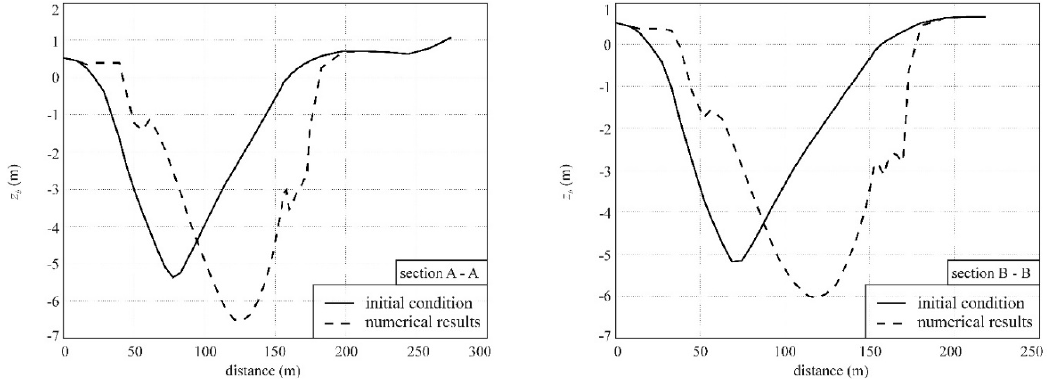
Figure 12. Meander migration in the Tagliamento River: cross sections A–A and B–B in the initial conditions and at the end of the five-year simulation.